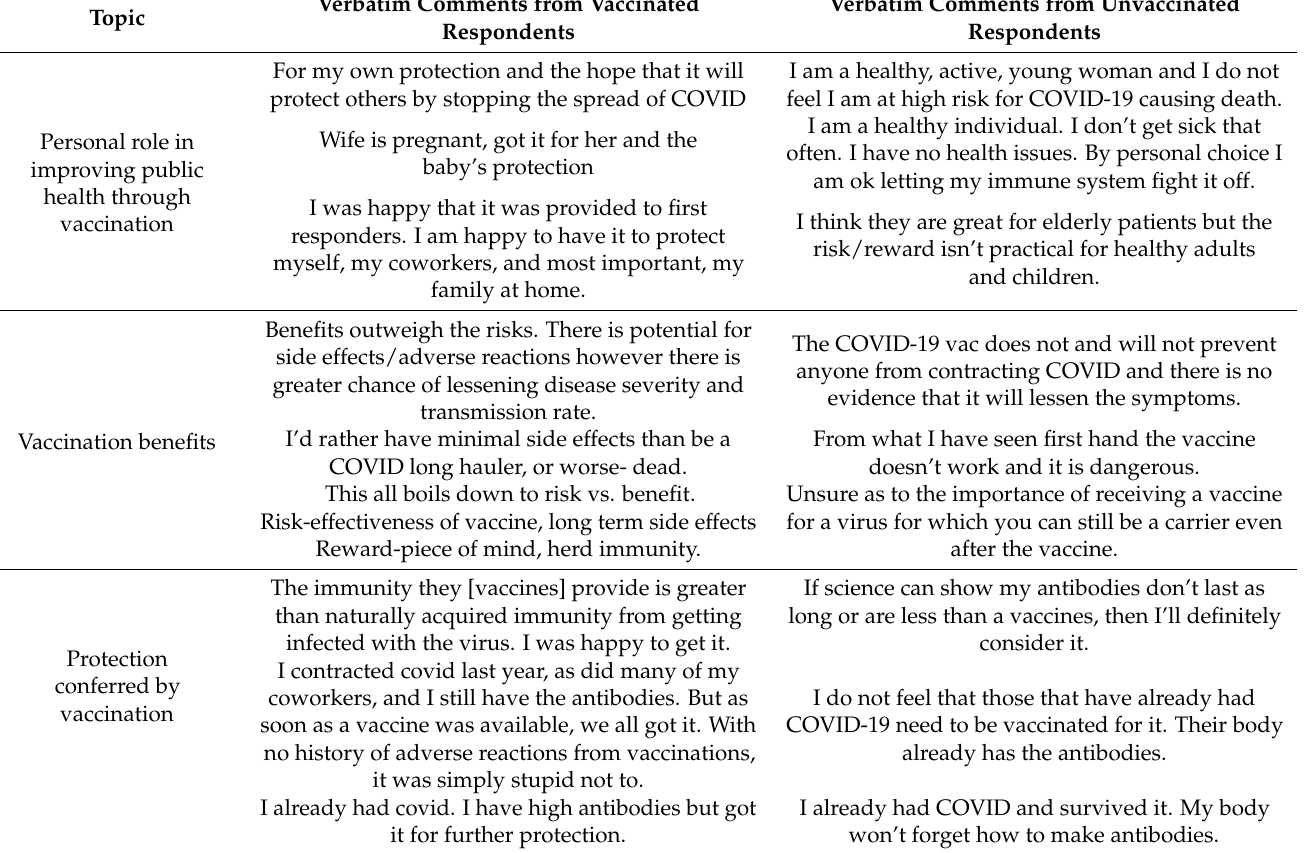
Table 2. Perspectives about personal responsibility for COVID-19